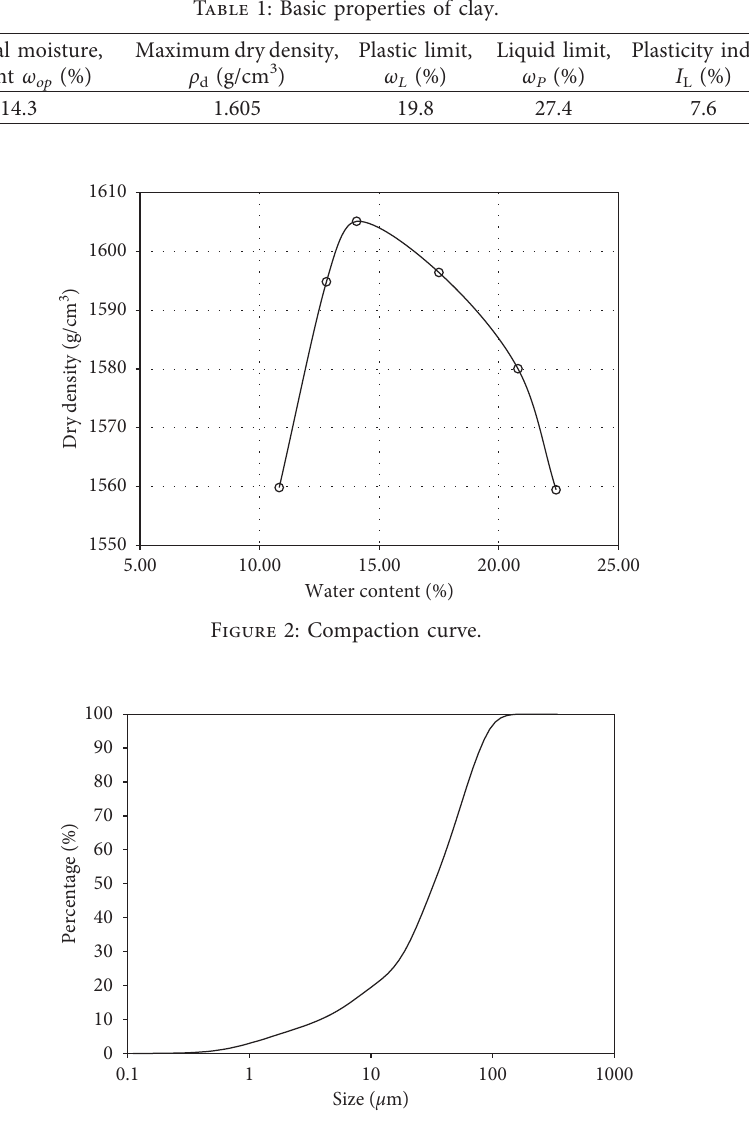
Figure 3: Gradation curve.